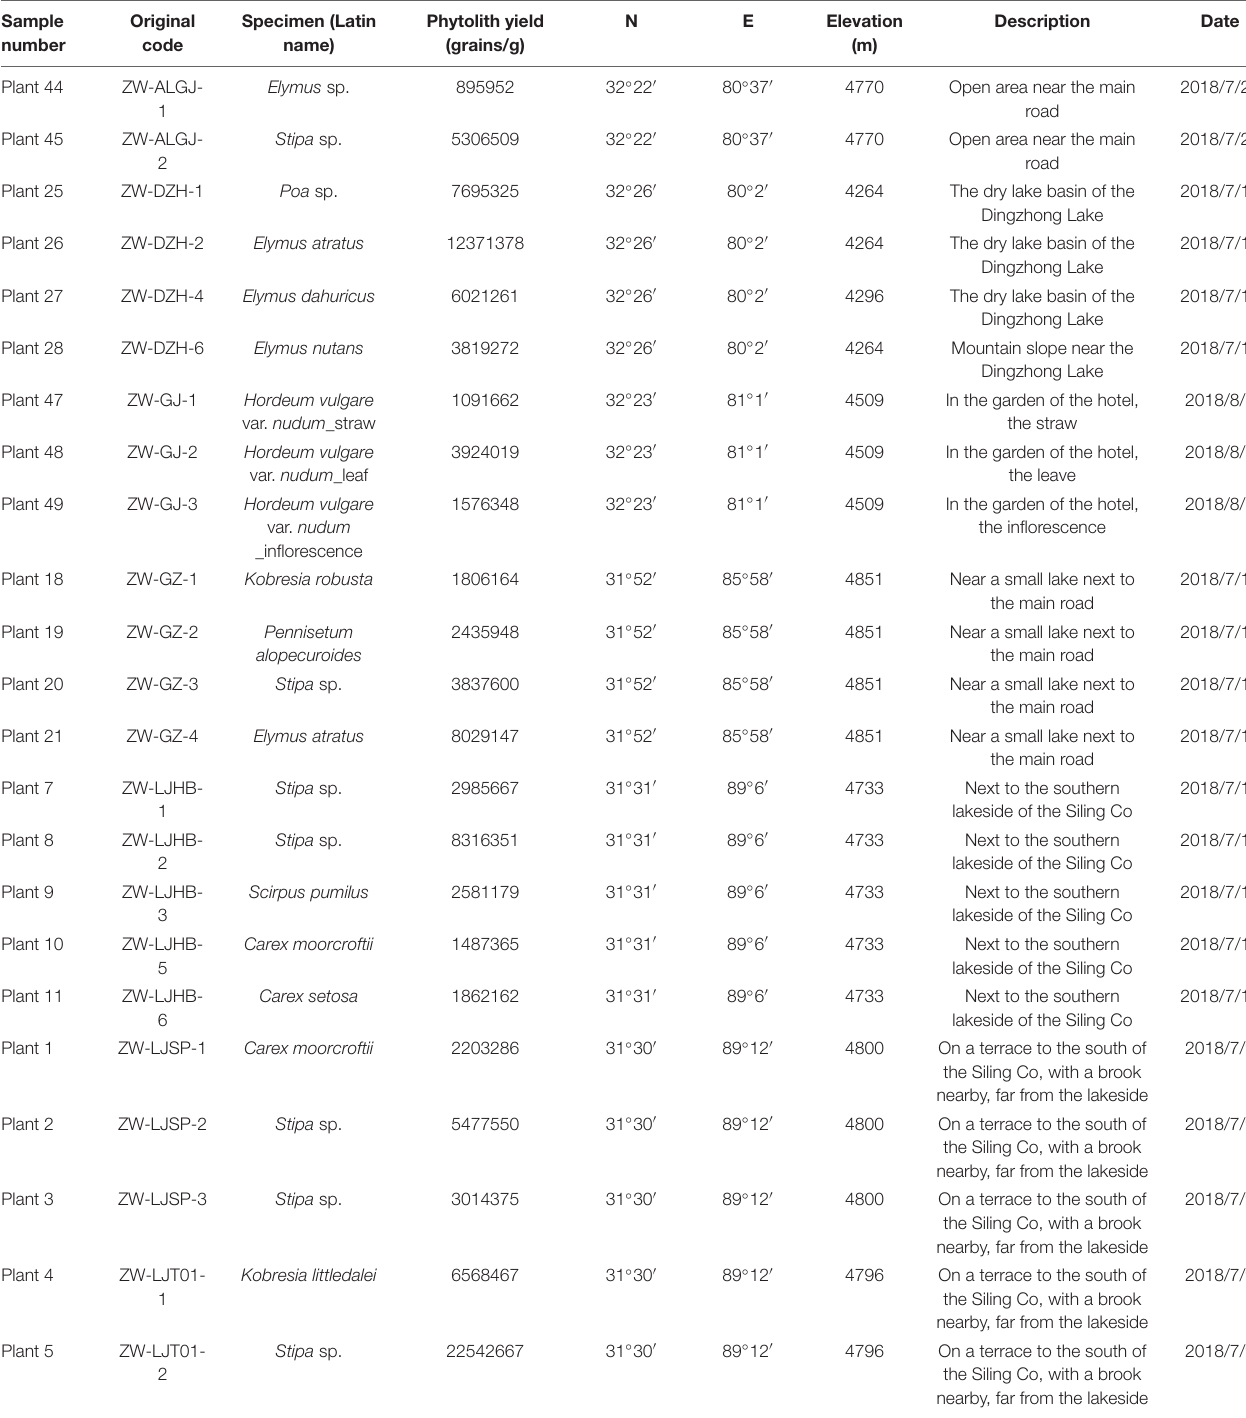
TABLE 1 | Sampling information and phytolith production of studied